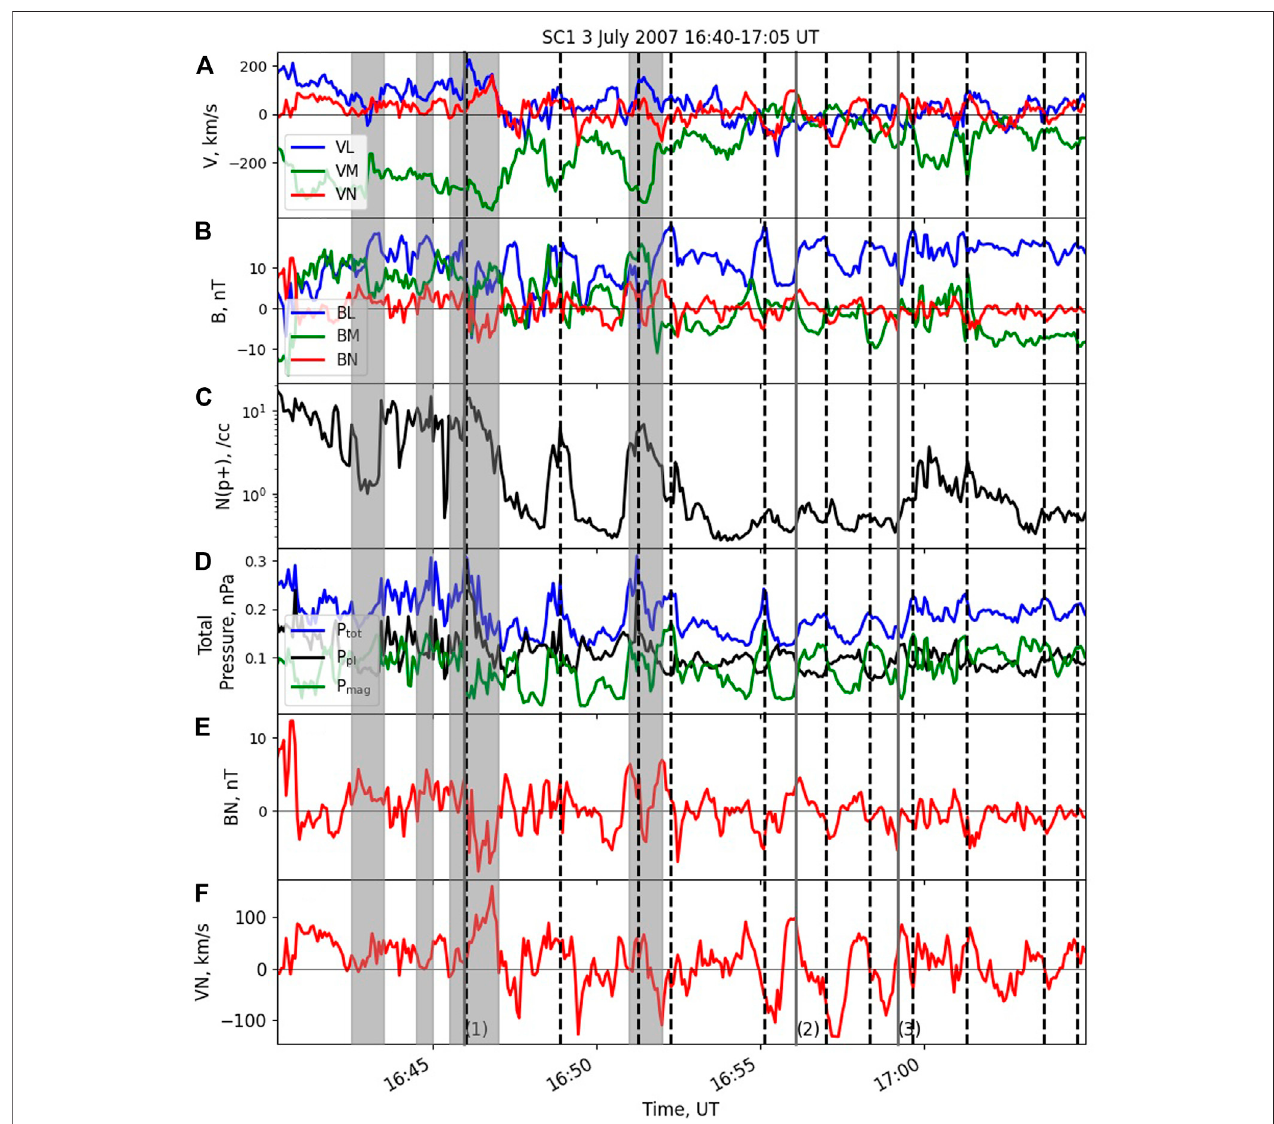
FIGURE 3 | SC 1 measured and derived parameter pro fi les for the KHI event on July 3, 2007 are shown for the time frame of 1640 – 1705 UT. From top to bottom withineachgraph: (A) transformedvelocitycomponentsL(blue),M(green)andN(red),km s − 1 ; (B) transformedmagneticcomponentsL(blue),M(green)andN(red),nT; (C) ion density (black), cm − 3 ; (D) total/plasma/magnetic pressure (blue/black/green), nPa; (E) transformed magnetic normal component (red), nT; (F) transformed velocity normal component (red), km s − 1 . The black vertical dashed lines indicate the times of strong maxima in the total pressure pro fi le. The vertical shadowed bars show the locations of rotational discontinuities. The grey vertical solid lines denoted as (1), (2) and (3) indicate time intervals for which fi eld-aligned beams were observed (see Figure 8 ).